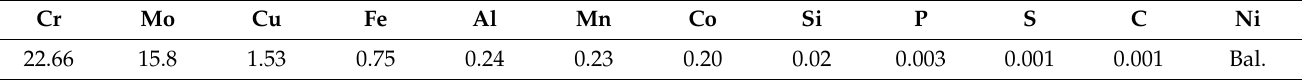
Table 1. Chemical composition of as-received C-2000 alloy bar